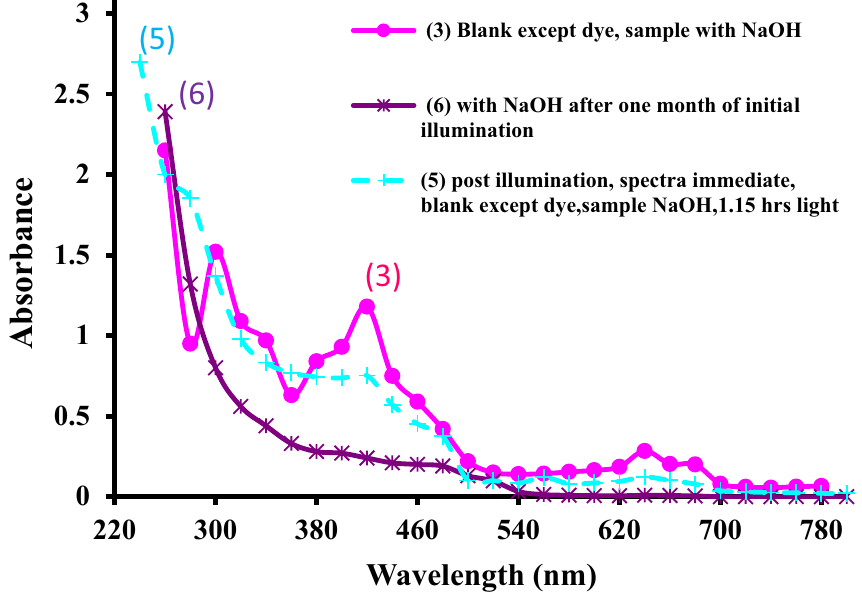
Figure 2. Effect of the illumination on the spectra of extract in the presence of NaOH, NaLS, and Fructose [curve line 5, main spectral property: a spectrum was taken immediately after illumination. Absorbance slightly, but continuously increasing towards the shorter λ, broad band at 420 nm (A 0.75 ), very broad band 640 nm (A 0.122 ), shoulder band at 480 nm (A 0.37